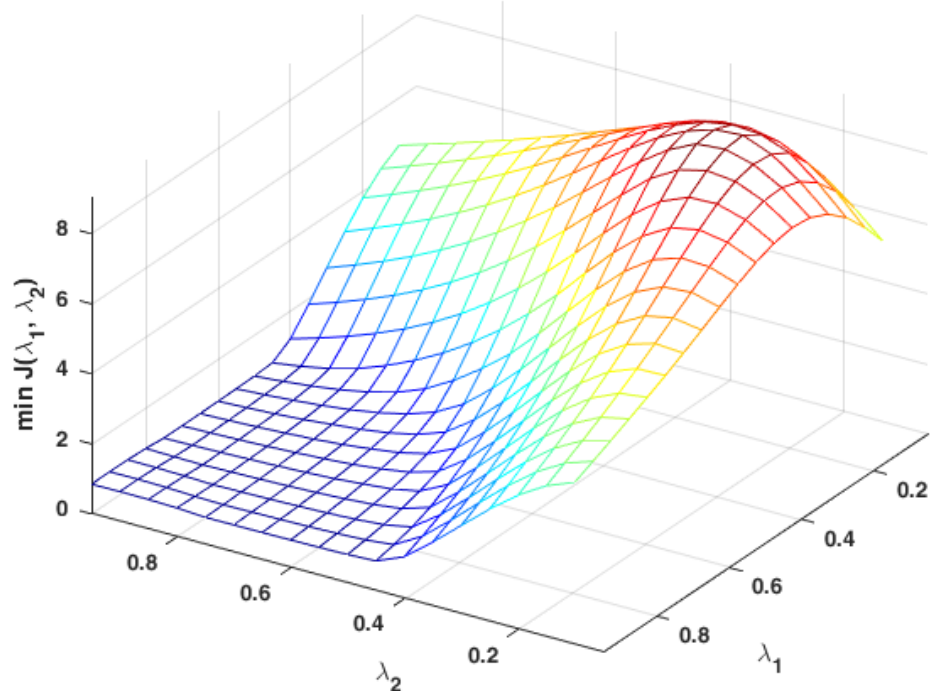
Figure 3. Function Surface (33), which depicts minimum achievable error for different values of unstable